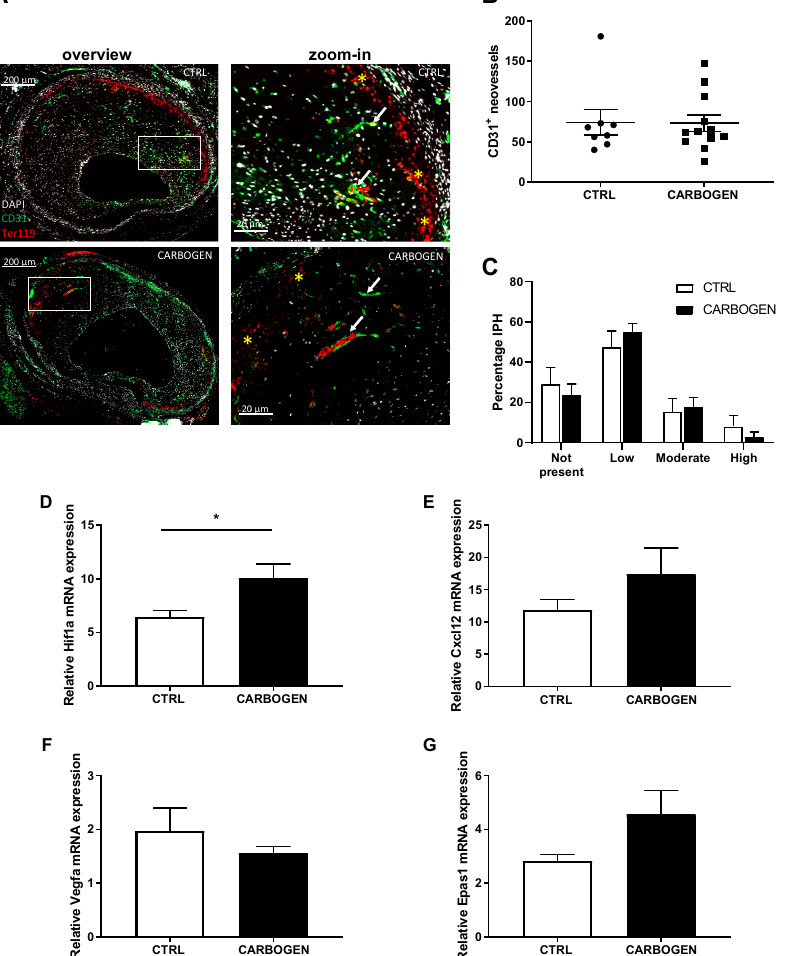
Figure 5. Chronic carbogen treatment does not a ff ect intraplaque neovascularization. ( A ) Representative pictures of vein grafts lesions stained for DAPI (white), CD31 (green) and Ter119 (red). ( B ) Quantification of CD31 positive neovessels in the vessel wall area in the control group ( n = 8) and in the carbogen treated group ( n = 12). ( C ) Bar graphs representing the quantitative measurements for IPH in the control and long term carbogen treated groups. IPH was scored as not present, low, moderate or high. Total vessel wall gene expression of ( D ) Hif1a, ( E ) Cxcl12, ( F ) Vegfa and ( G ) Hif2a, relative to Hprt, was measured in the control and long term carbogen treated groups. Data are presented as mean ± SEM. * p < 0.05; by two-sided Student’s t